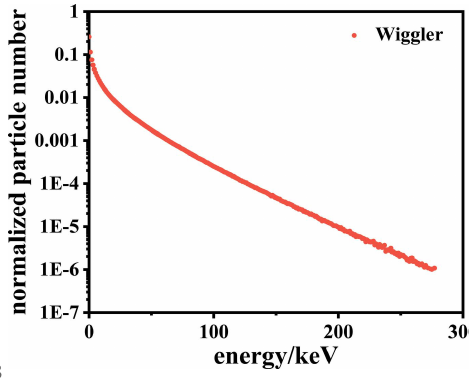
Figure 3 Spectrum of the photon output from the